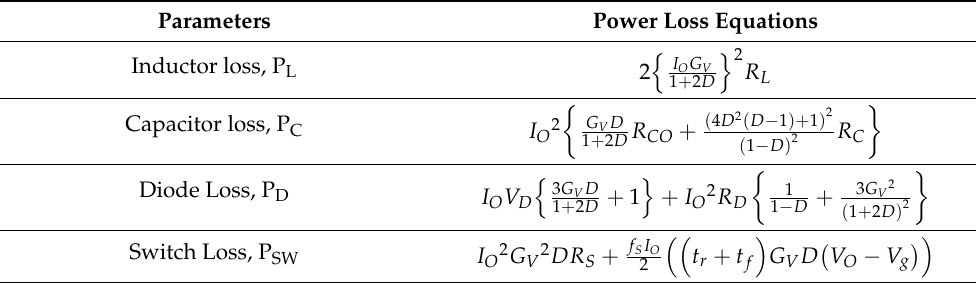
Table 3. Power loss equations of the proposed topology .